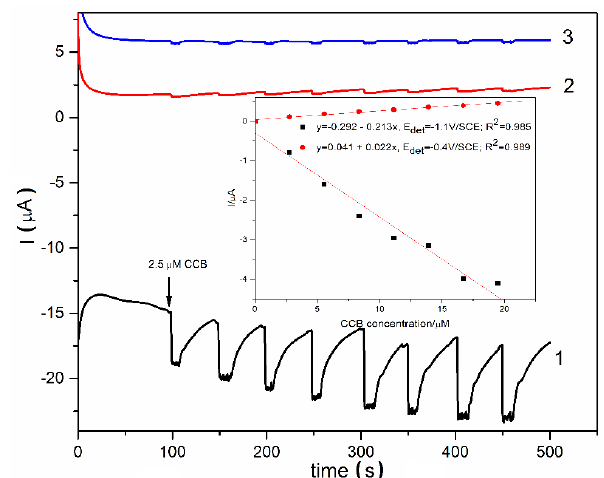
Figure 11. Multiple-pulsed amperograms (MPAs) recorded at the LaFeO 3 /BDD electrode in a 0.1 M NaOH supporting electrolyte and adding 2.5 µM CCB concentrations at three potential levels applied for time duration of 50 ms: −1.1 V/SCE (curve 1), −0.4 V/SCE (curve 2), and 0.4 V/SCE (curve 3). Inset: Calibration plots of current vs CCB concentrations for −1.1 V/SCE and −0.4 V/SCE.